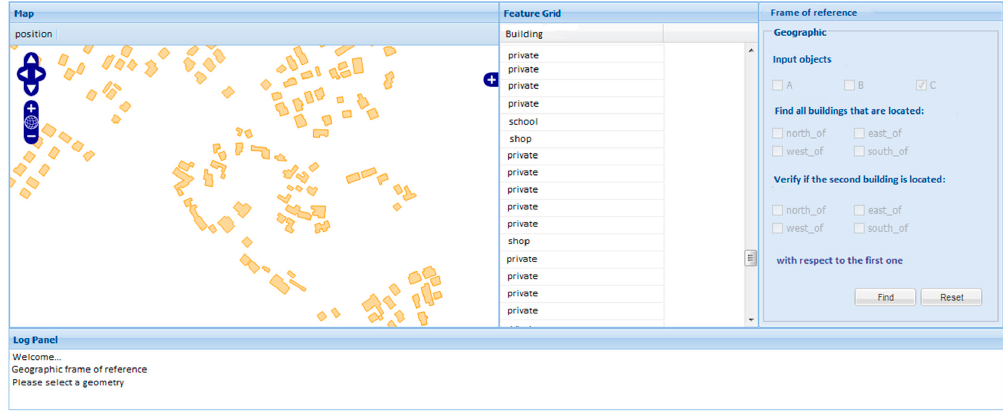
Figure 12. The main window of the application.